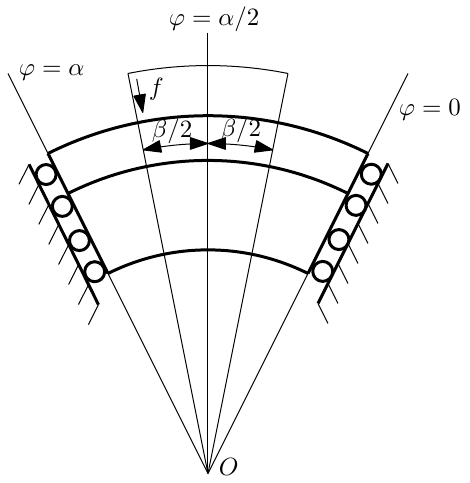
Figure 4: Uniformly loaded curved composite